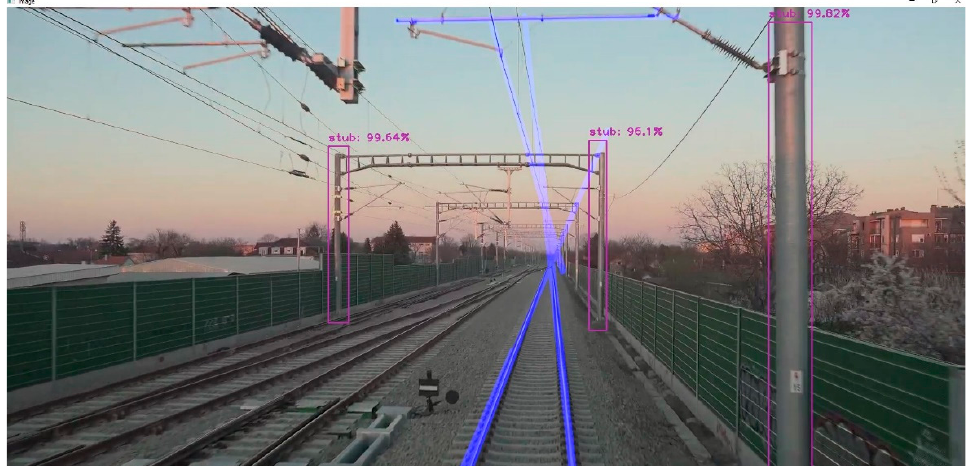
Figure 16. Overhead system detection—catenary rail lines and contact line mast—test image 1.